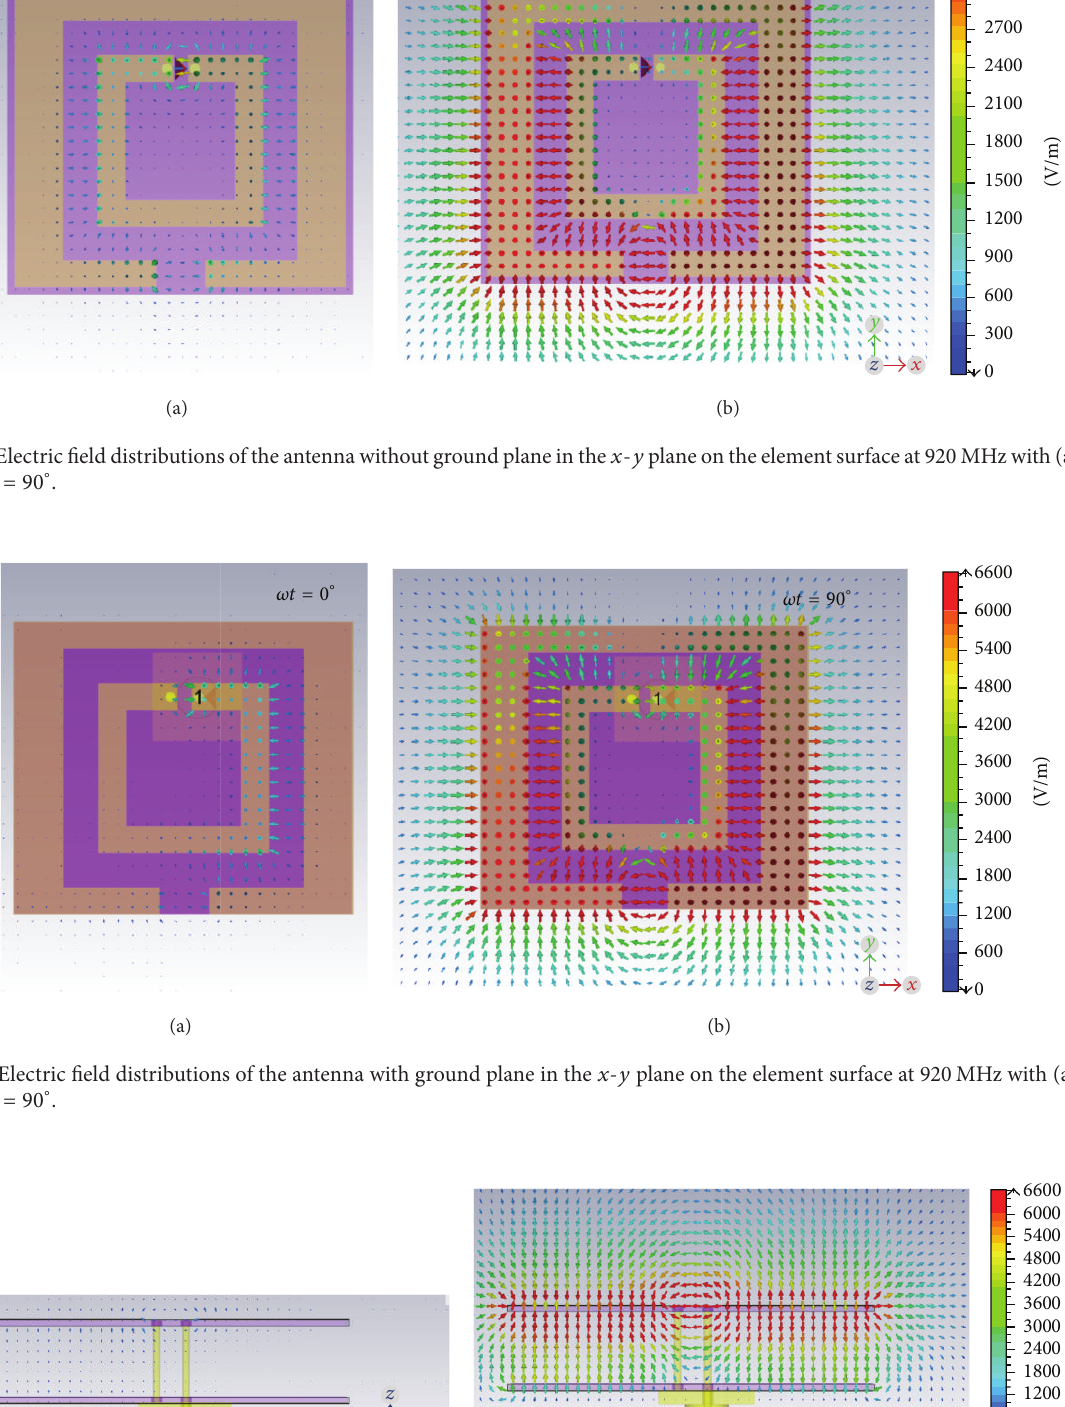
Figure 9: Electric field distribution in the 𝑥 - 𝑧 plane at a distance of 20 mm from the center of substrate along the 𝑦 -axis (a) at 𝜔𝑡 = 0 ∘ and (b) at 𝜔𝑡 = 90 ∘